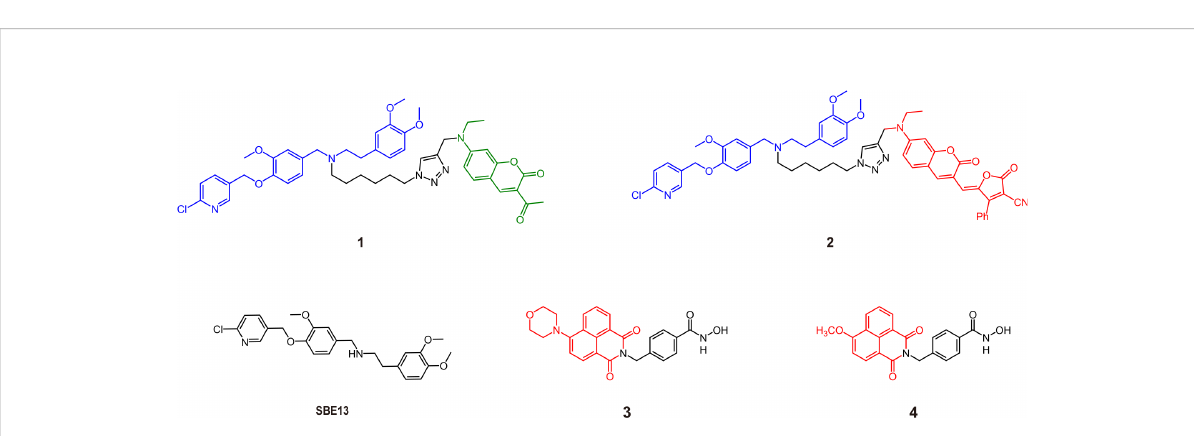
FIGURE 1 Some structures of traditional visible AfPIs and their parent inhibitors (Blue, inhibitor structure; green and red, fl